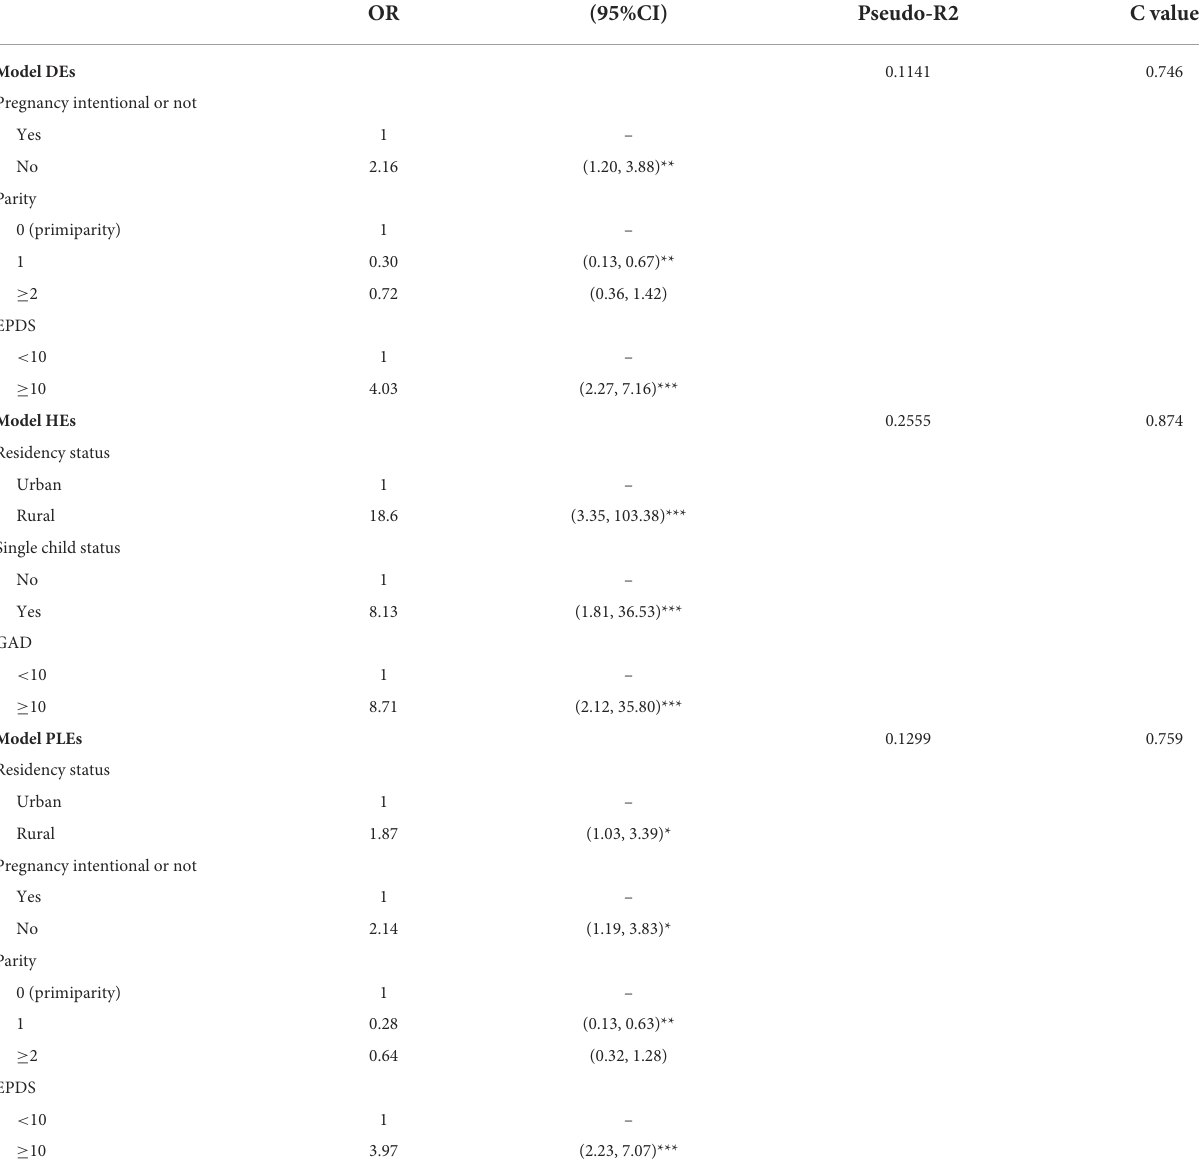
TABLE 3 Influential factors of high frequent delusional experiences (DEs), hallucinatory experiences (HEs), and PLEs in pregnant